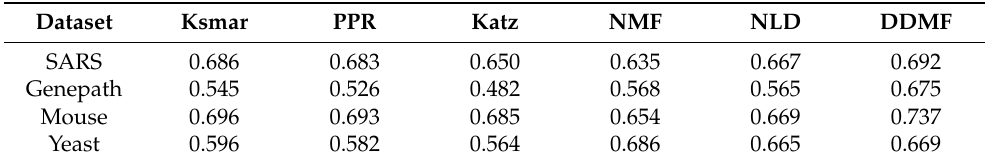
Figure 3. Recall rate results in four networks: ( a ) SARS network; ( b ) Genepath network; ( c ) Mouse network; ( d ) Yeast network. network; ( d ) Yeast network. Table 2. AUC results in four networks. Table 2. AUC results in four